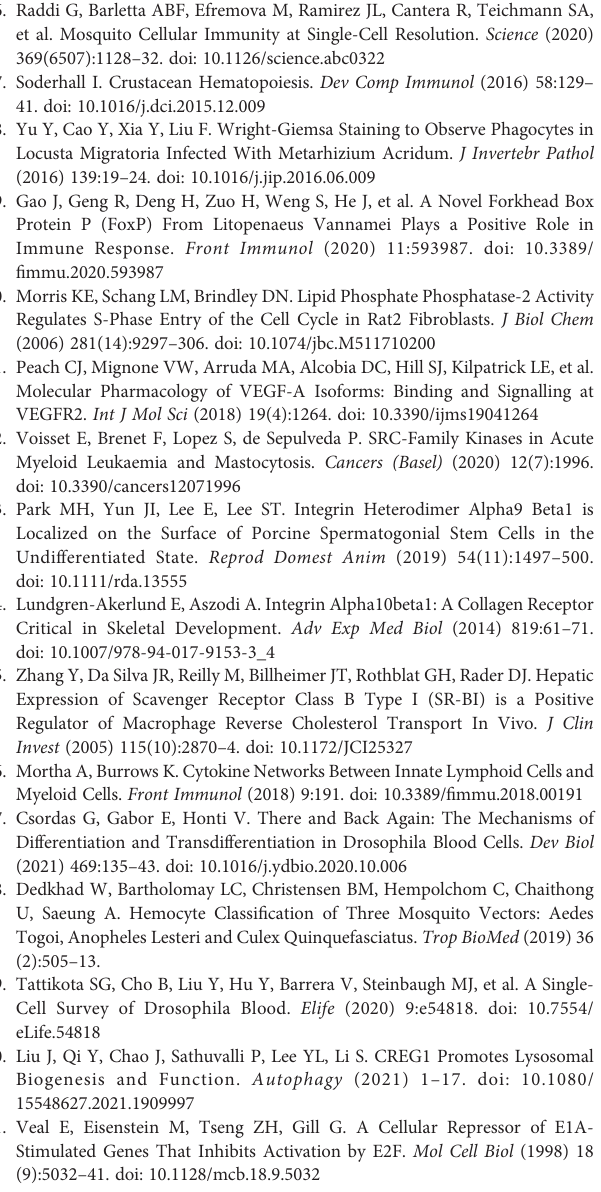
shrimps separately. FITC-labeled VP was injected at 72 h post-dsRNA injection. After another 8 h, the hemocytes were collected for immunoblot (A) and phagocytic assay (B) . Each dot represents the test result of one shrimp. The data were analyzed by two-tailed unpaired Student ’ s t -tests compared with the control. Supplementary Table 1 | Differentially expressed genes between rEGFP- and rCREG-treated shrimp